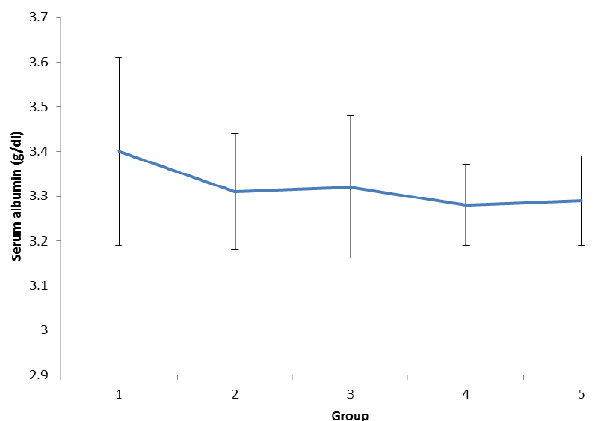
Fig. 4. Effects of quail egg on the serum levels of albumin of alloxanized